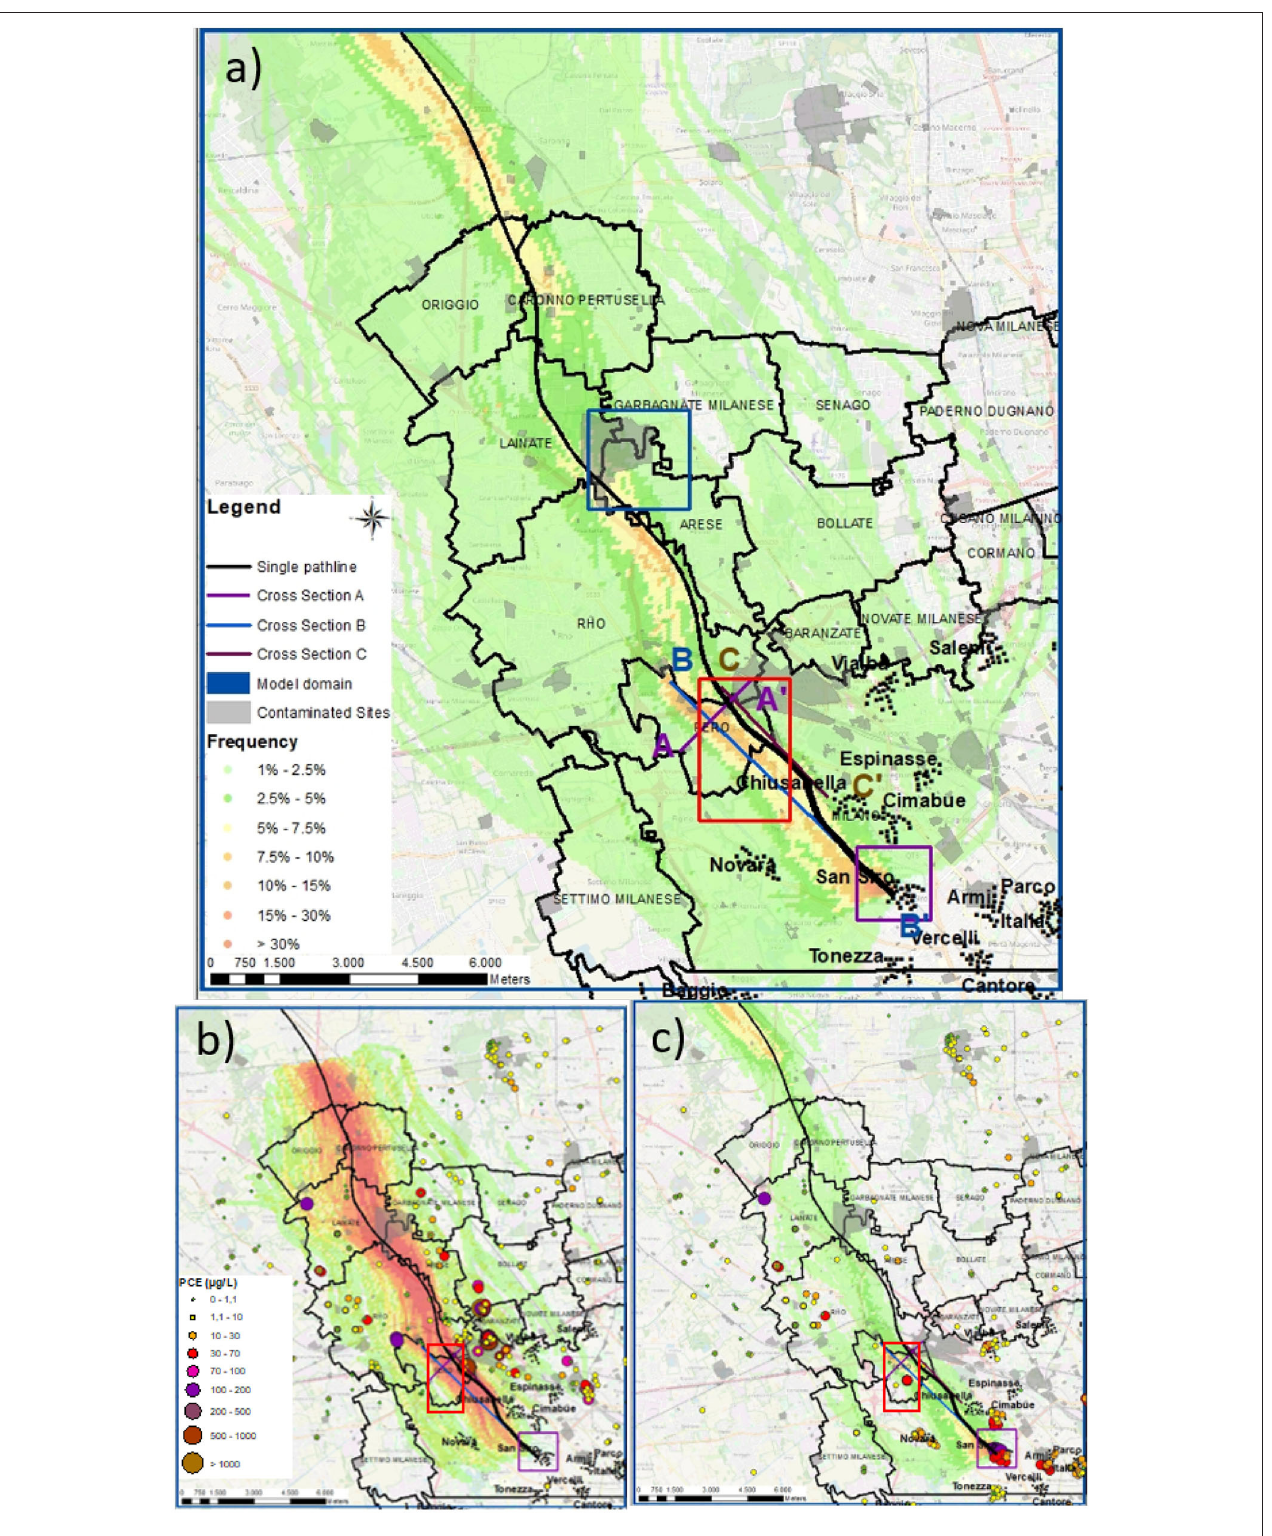
FIGURE 7 | Particle frequency distribution of the ensemble backtracked pathlines for (a) all layers, (b) Aquifer A, and (c) Layer 5, representing the more affected sector of Aquifer B. Particle tracking has been carried out for all 336 accepted and re-calibrated model realizations. To represent the particle passage frequency, a threshold value of 1% was set in all maps. Black lines represent the pathlines resulting from the native deterministic model.